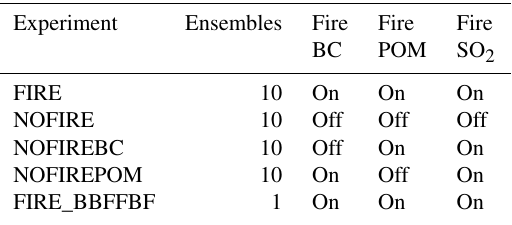
Table 1. Numerical experiments and associated fire aerosol emis- sions in each experiment. Experiment